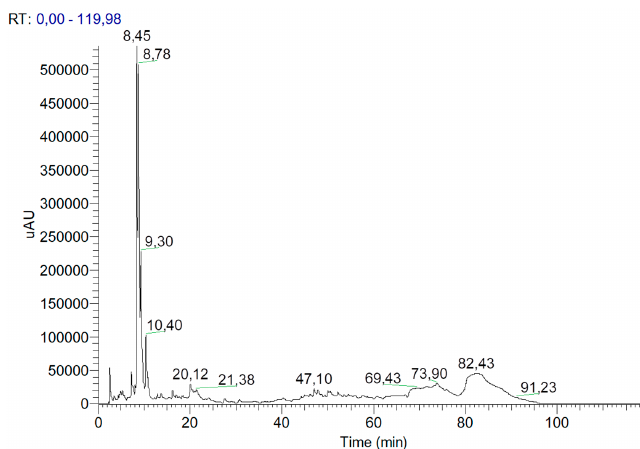
Figure 3. The chromatographic profile at 280 nm of the extract present in the formulation analysed by HPLC. These results showed a high capability of encapsulation of the phytosomes for the extract.